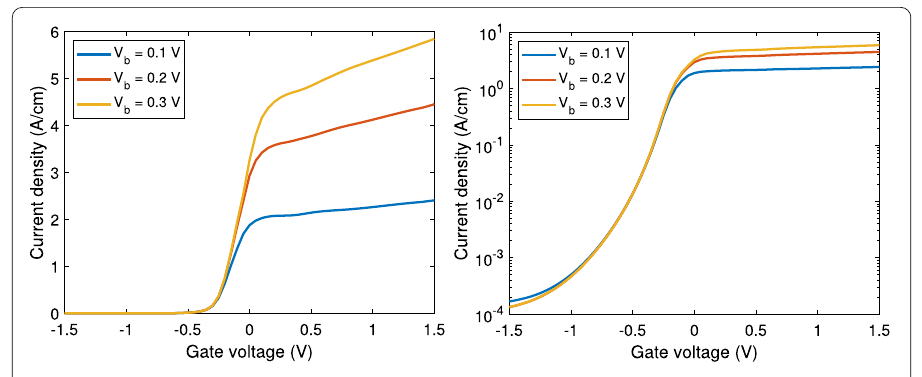
Figure 2 Characteristic curves of the simulated GFET in linear scale (left) and logarithmic one (right). The adopted model is (1), (2)